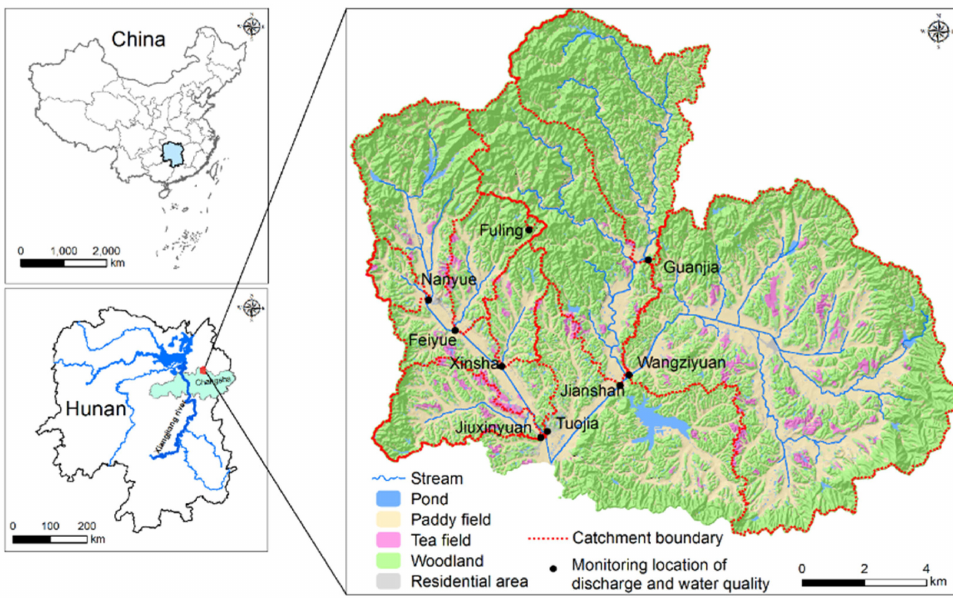
Figure 1. Topography, land use, and observations of the nine studied catchments in subtropical central China.